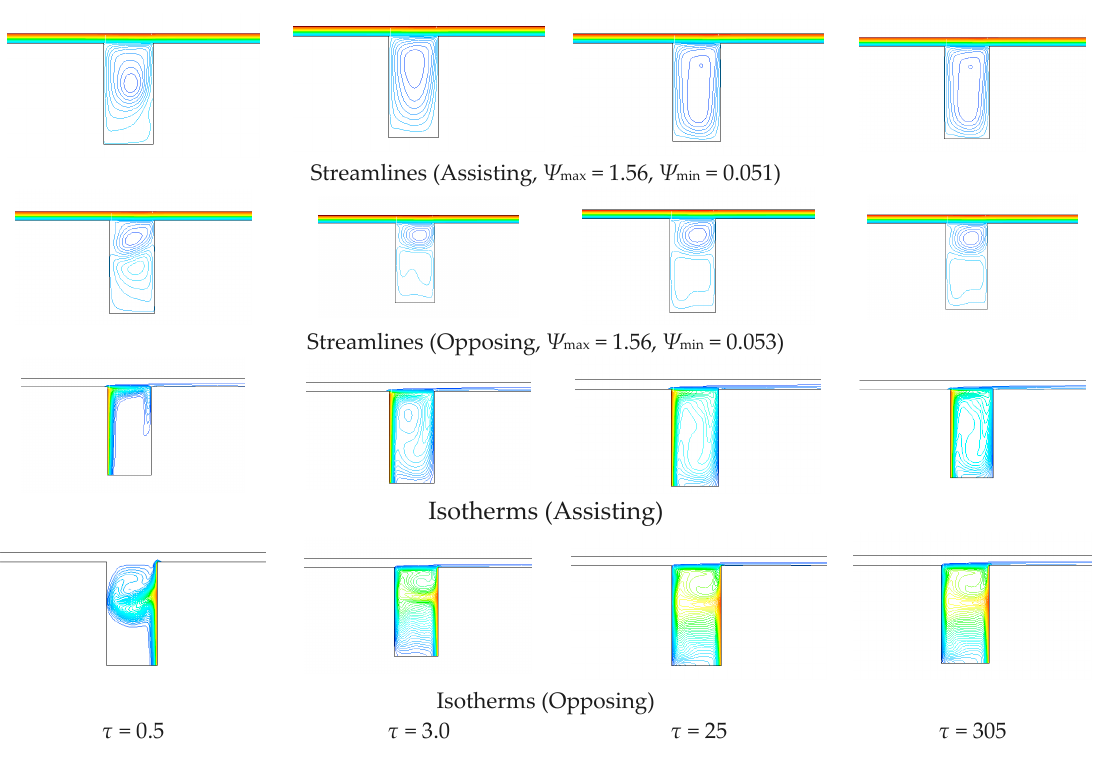
Figure 9. Streamlines and isotherms for Re = 1000, aspect ratio (AR) = 0.5 and Ri = 6.54.